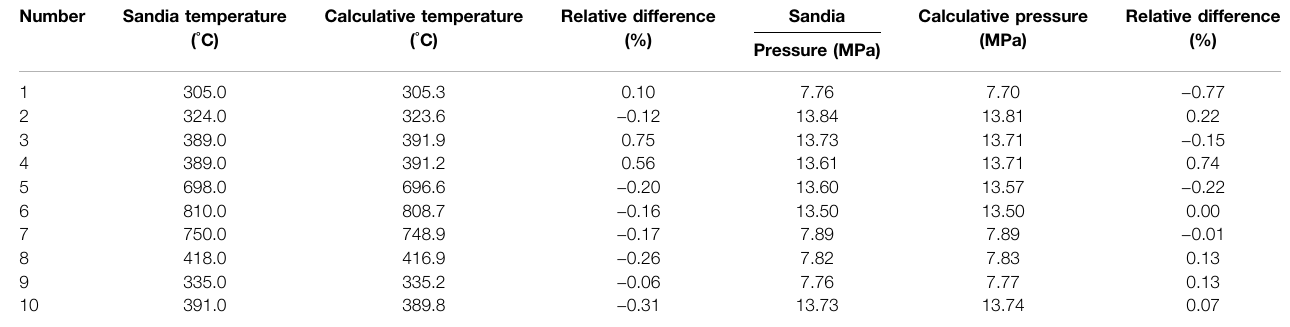
TABLE 1 | The steady-state simulation results of the temperature compared with Sandia values. Number